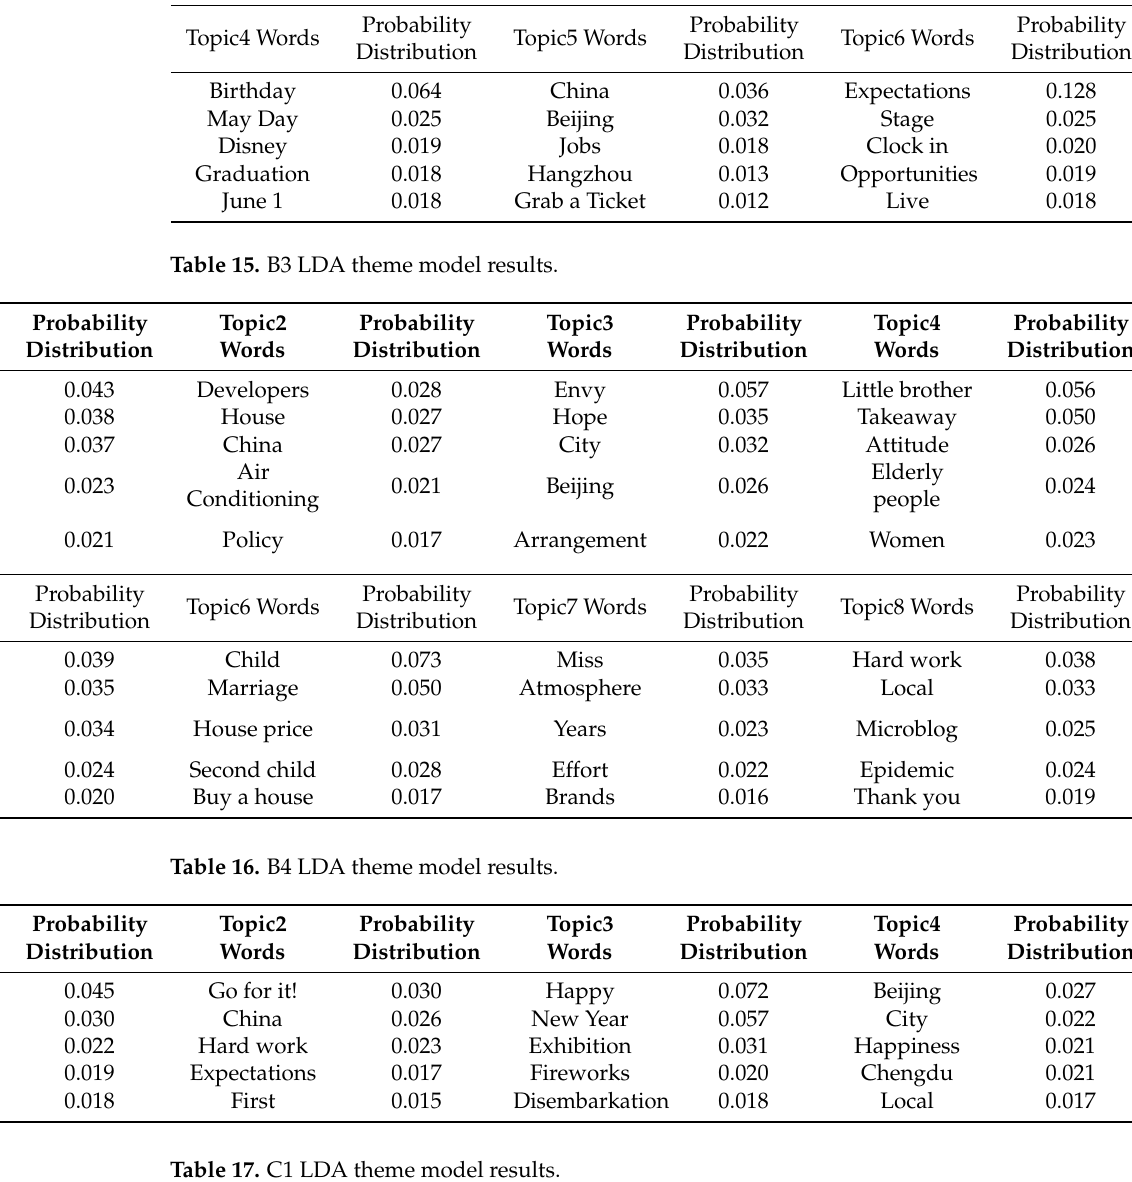
Table 17. C1 LDA theme model